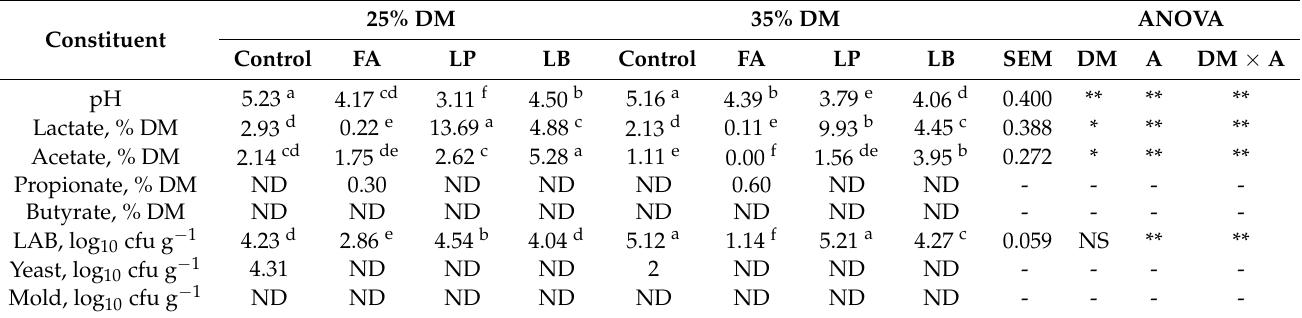
Table 2. Fermentation characteristics and microbial composition of Italian ryegrass ensiled for 60 d.